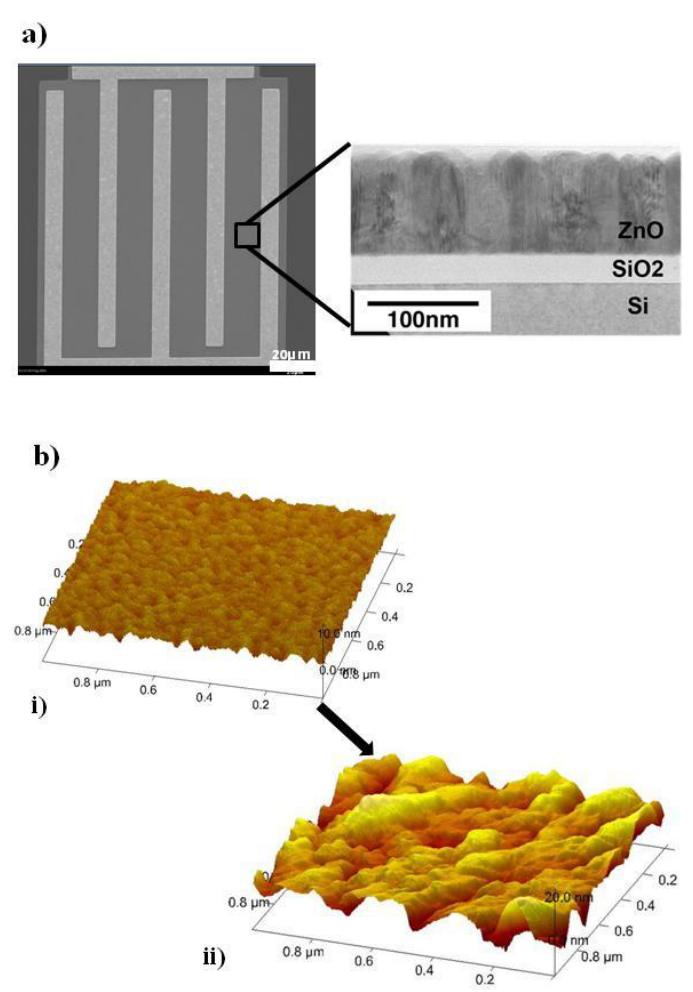
Figure 2. ZnO-FET electron and atomic force microscopy: ( a ) scanning electron micrograph of the interdigitated electrode FET configuration and transmission electron micrograph of the FET cross-section, and ( b ) atomic force micrograph after (i) silane linker functionalization and after (ii) aptamer functionalization via silane